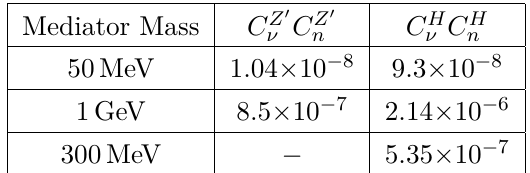
Table 1. The values of the overall couplings for the vector and scalar mediators for different values of mediator masses to produce 560 N